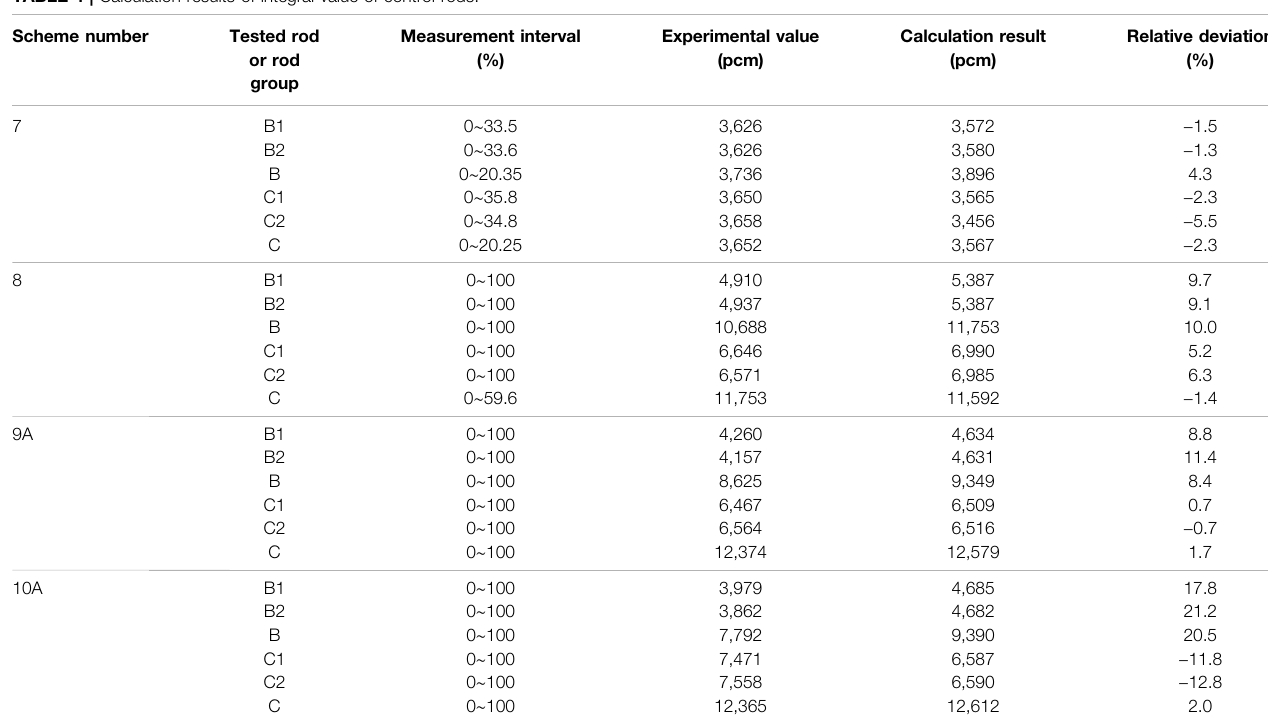
TABLE 4 | Calculation results of integral value of control